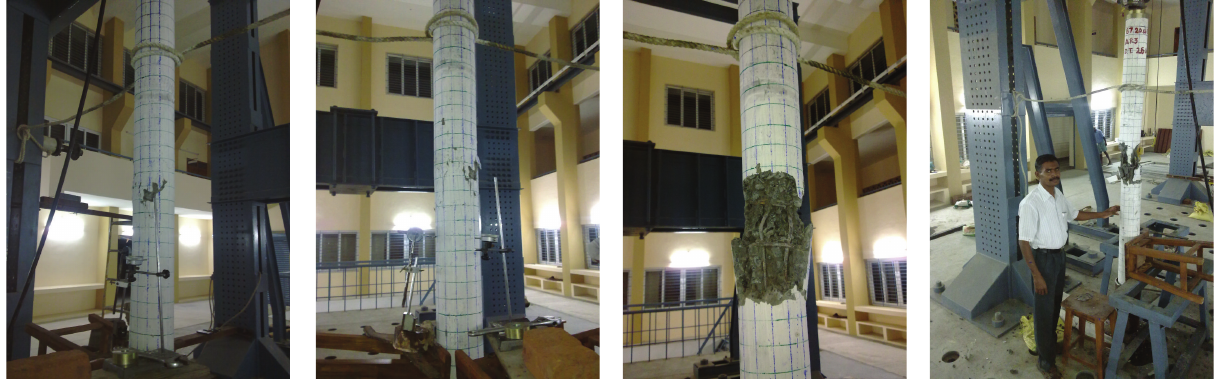
Figure 6: Conventional elements testing.